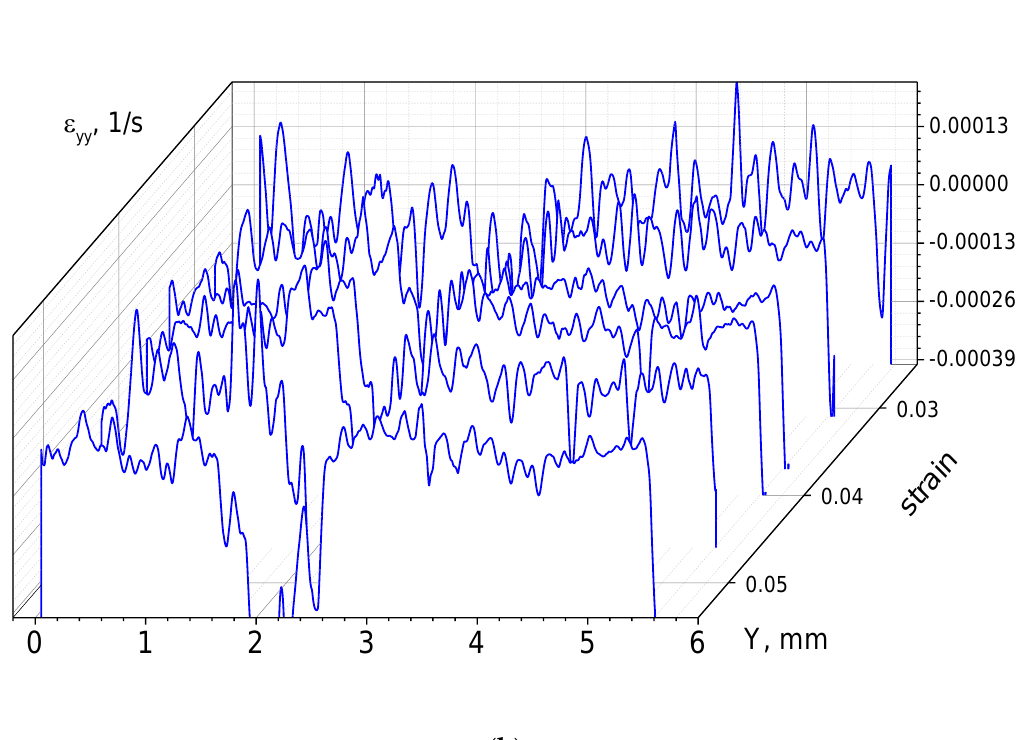
. ε xx ( X , Y = Y m /2 ) ( a ) and